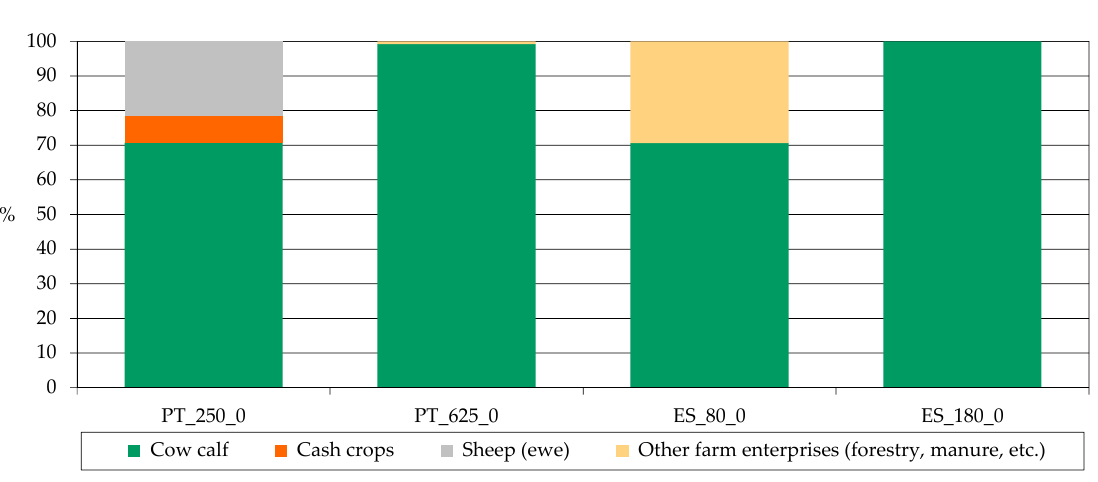
Figure 1. Return Structure (% of different farm activities on total farm returns). Source: model results.